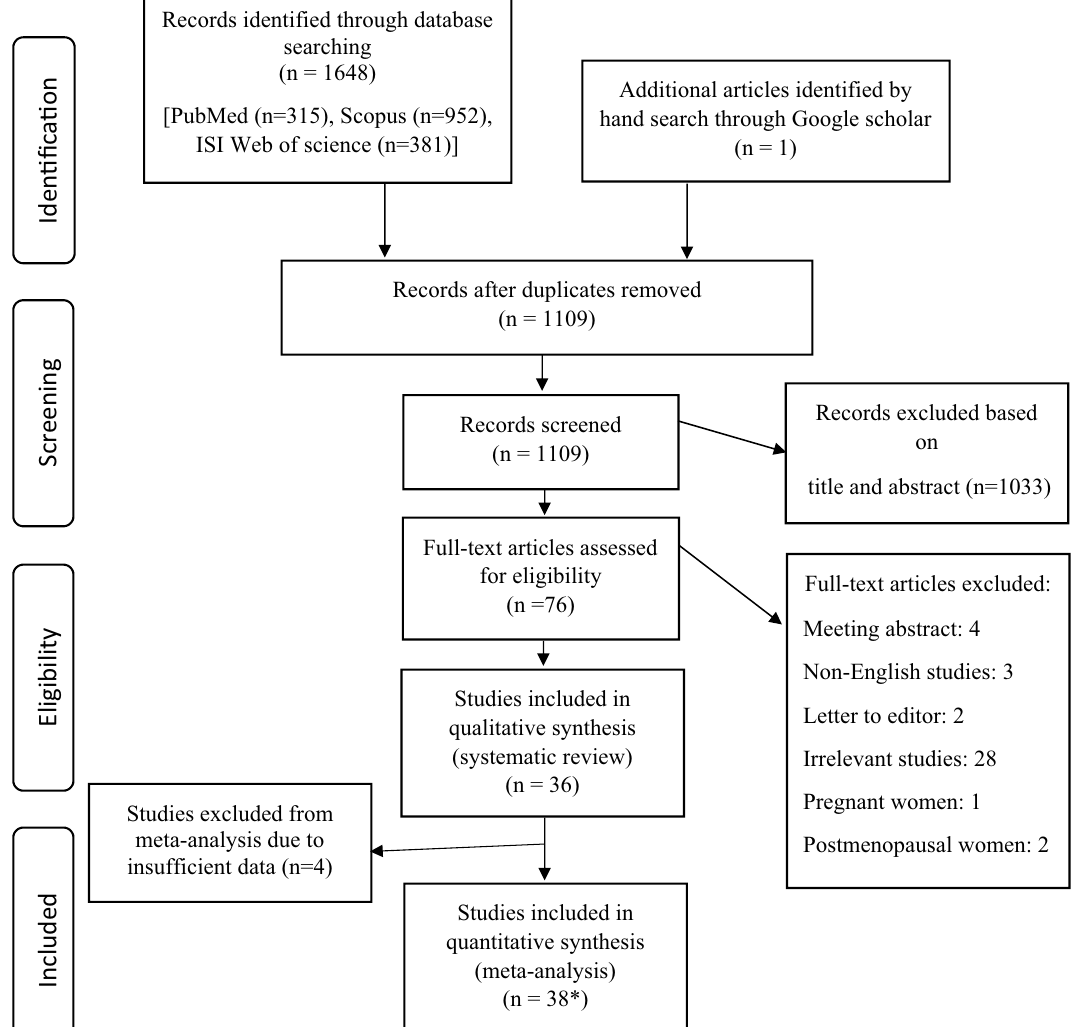
Figure 1. The flow diagram of study